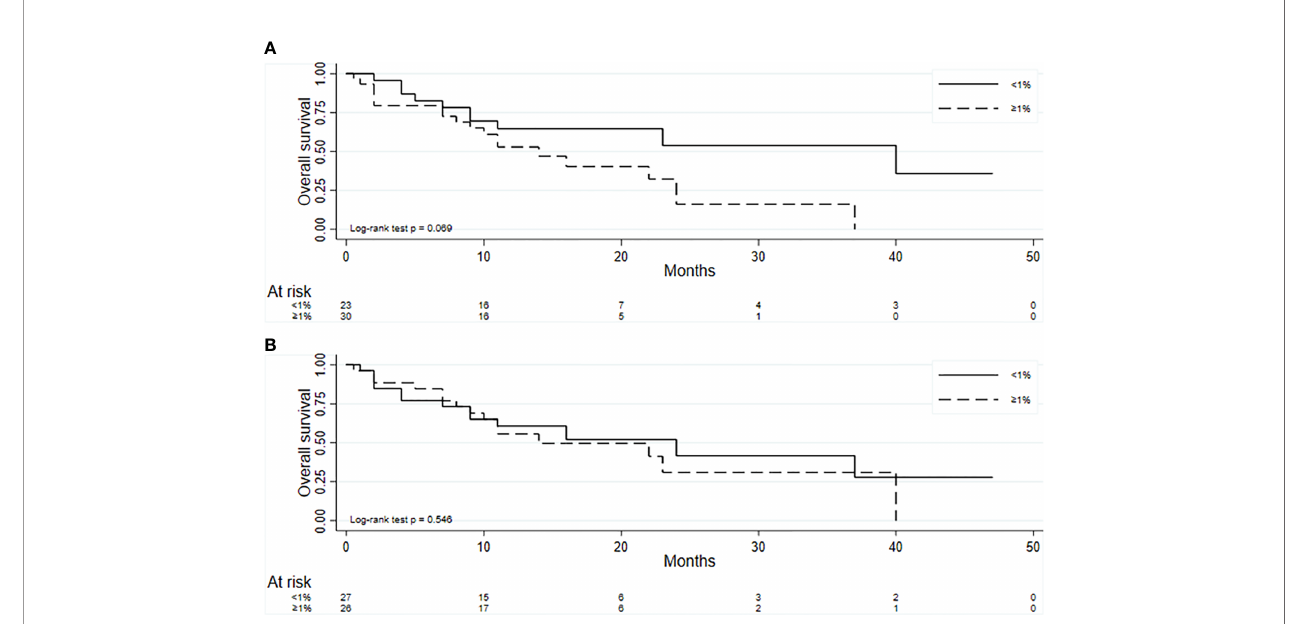
FIGURE 5 | Kaplan-Meier curves for OS for PD-L1 (A) and vimentin (B)